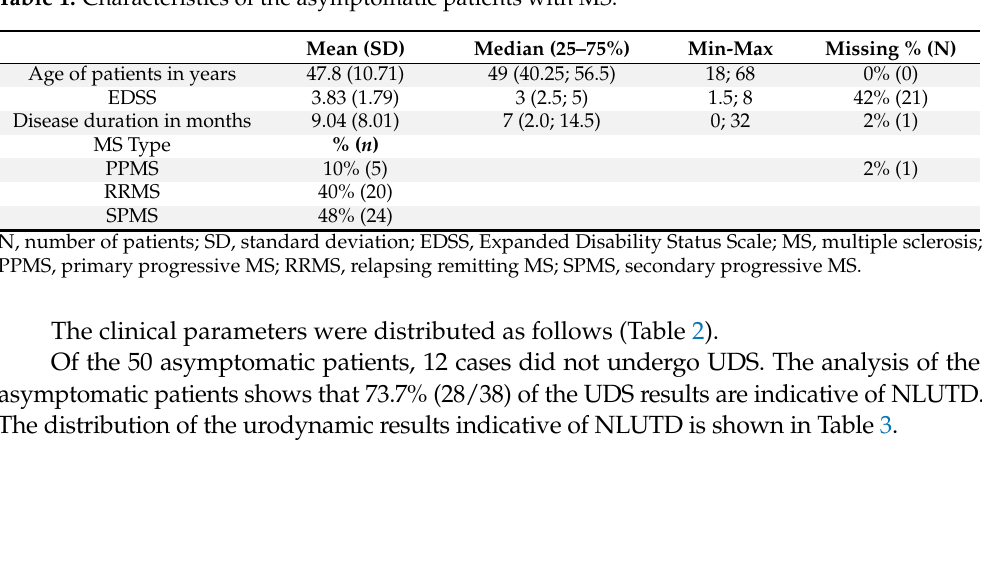
Table 1. Characteristics of the asymptomatic patients with